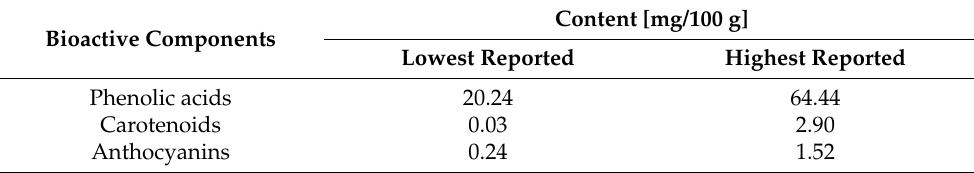
Table 3. Bioactive compounds in date fruit at tamer stage (mg/100 g fresh weight). Adapted from